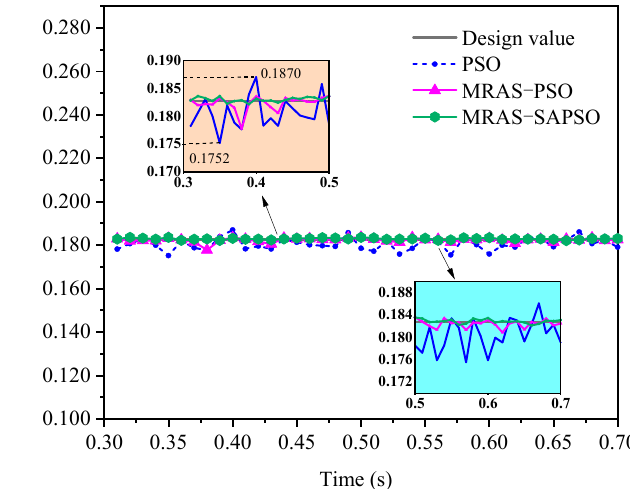
Figure 11. Magnetic linkage identification curve.